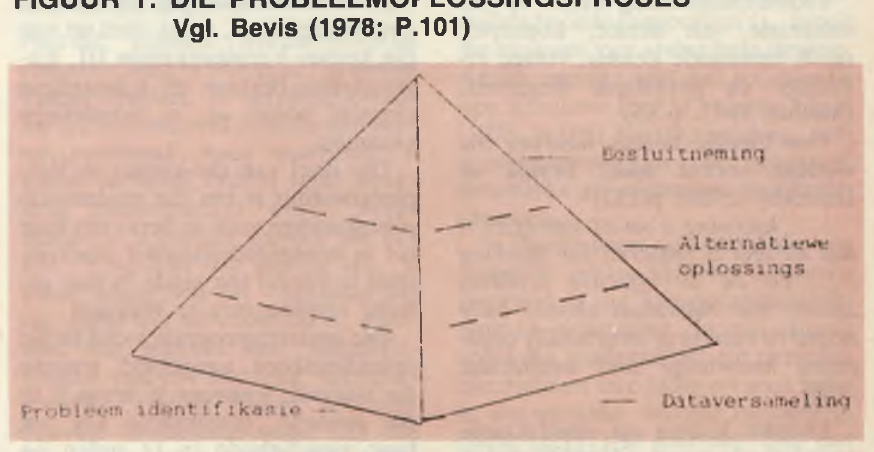
FIGUUR 1: DIE PROBLEEMOPLOSSINGSPROSES Vgl. Bevis (1978: